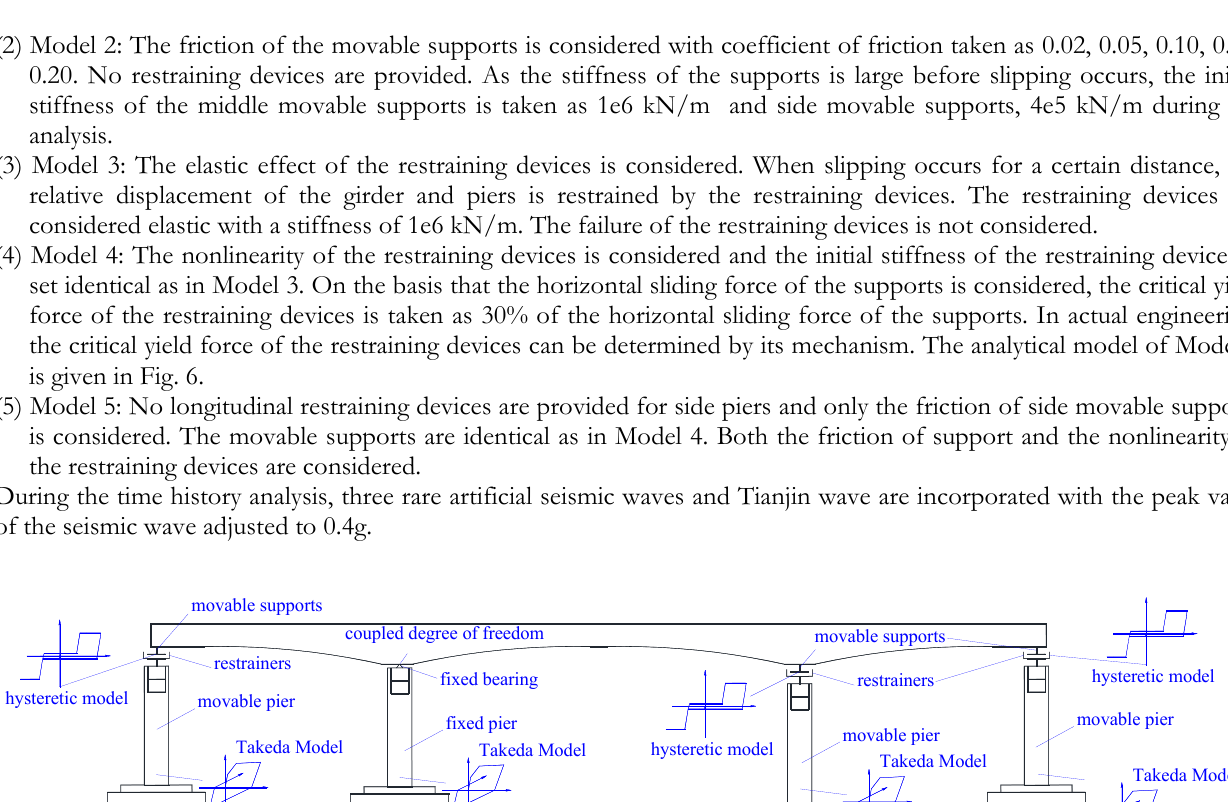
Figure 5: Numerical FE model.